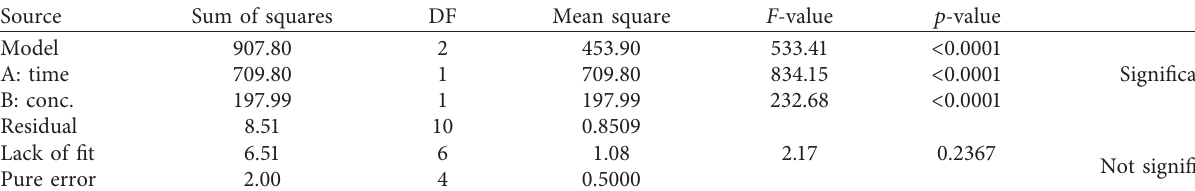
Table 4: Analysis of variance (ANOVA) of the ethanol extraction yield.